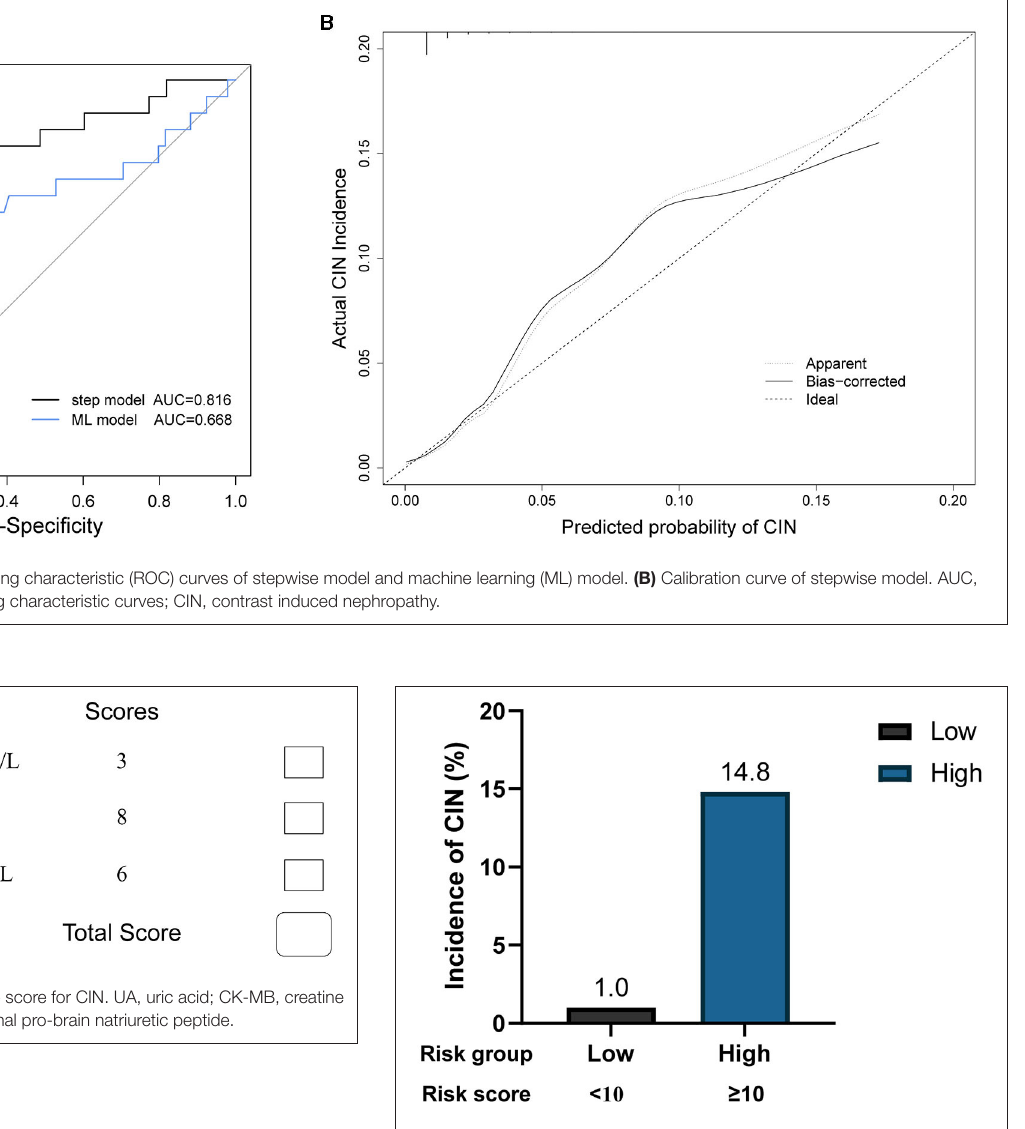
FIGURE 4 | CIN incidence based on different risk groups. CIN, contrast induced